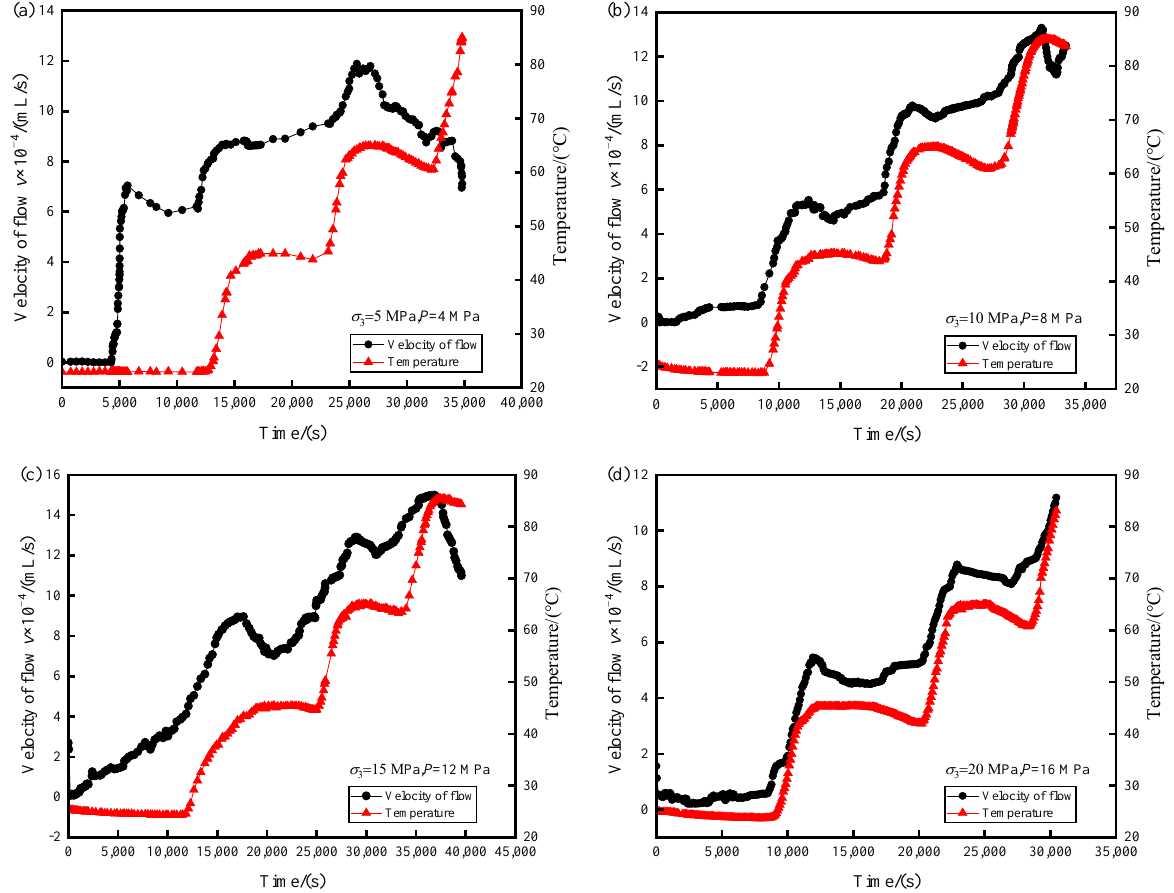
Figure 6. Variation law of temperature and flow rate with ( a ) σ 3 = 5 MPa, P = 4 MPa; ( b ) σ 3 = 10 MPa, P = 8 MPa; ( c ) σ 3 = 15 MPa, P = 12 MPa; ( d ) σ 3 = 20 MPa, P = 16 MPa As can be seen from Figure 6, when the confining pressure was 5 MPa, 10 MPa, 15 MPa or 20 MPa, the change trends of the velocity – time – temperature curves were roughly the same during the seepage test process. In each case, there was an increase followed by a small decrease in the velocity of water flow, due to the continuous action of the load. The volume compression of the coal specimen caused the internal cracks and pores to close, and the temperature increased under the lower confining pressure condition (σ 3 = 5 MPa), which significantly increased the water-production speed. This was mainly because the volume compression reduced the channels of water flow, and the dynamic viscosity of the water decreased, which accelerated the movement of water molecules and caused faster flow in the existing cracks and pores inside the coal specimen. As can be seen from the water velocity curve, the change was small in the early stage, showing an upward – downward trend. The main reason for this was that during the heating process, the inte- rior of the coal specimen was not uniformly heated, resulting in different temperatures of water in the coal specimen, different dynamic viscosities of fluids at different positions in the coal specimen, and different rates of molecular diffusion. Additionally, the non-uni- form temperature led to inconsistent thermal expansion around the coal specimen, and the fissures inside the coal specimen differed considerably, resulting in unstable velocity of outflowing water. When the internal temperature of the coal specimen was stable, the water entering the coal specimen was heated evenly, and the diffusion of water molecules was in a stable state so the water outlet velocity curve tended to rise steadily. Along with